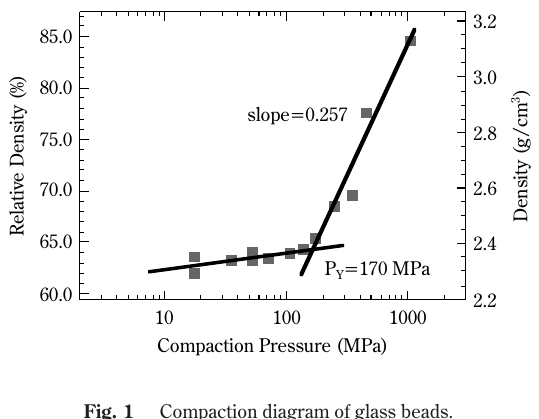
Fig. 1 Compaction diagram of glass beads.